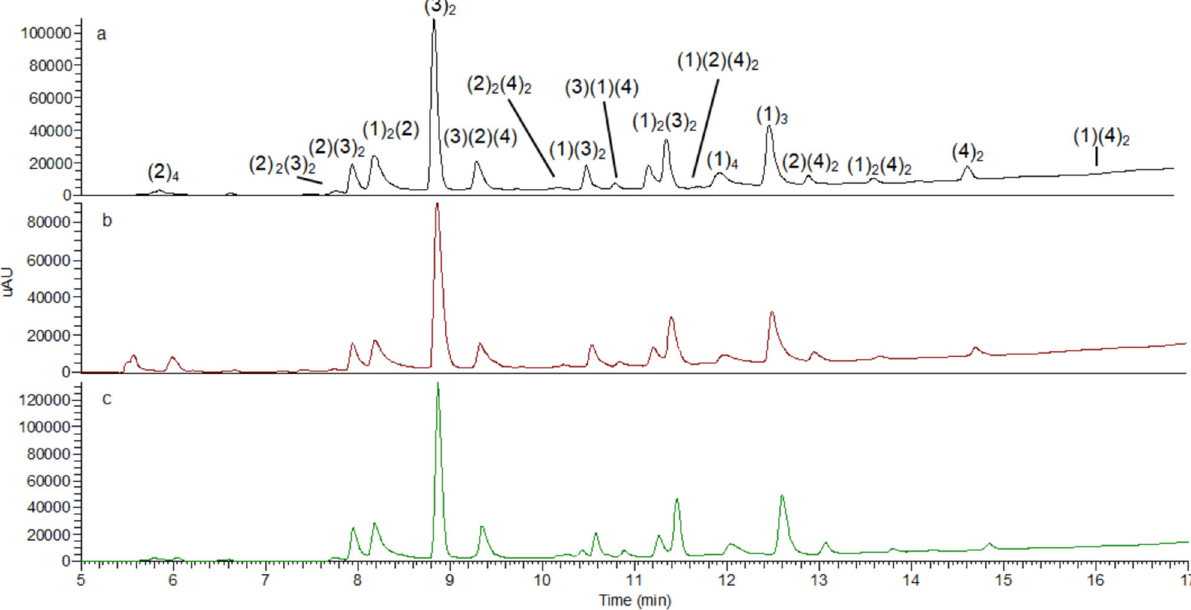
Fig. 4 DCL chromatograms comparing disul fi de (Cys ox ) and diselenide (Sec ox ). DCL conditions: building blocks ( 1 – 2 ) 95 μ M each ( 3 – 4 ) at 190 μ M concentration each. Tris buffer 20 mM, pH 7.8, 6 °C. a Control after 96 h. b Cys ox (190 μ M) after 72 h. c Sec ox (190 μ M) after 24 h. Experiments were performed in